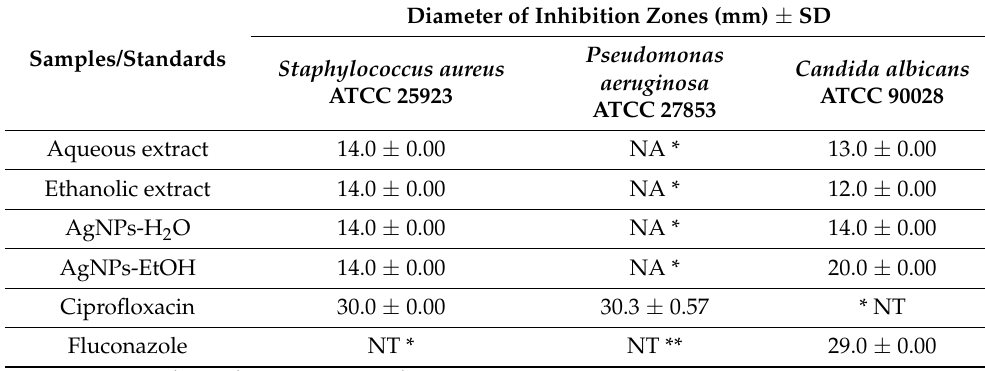
Table 3. Antimicrobial activity of the plant extracts and of the corresponding AgNPs.